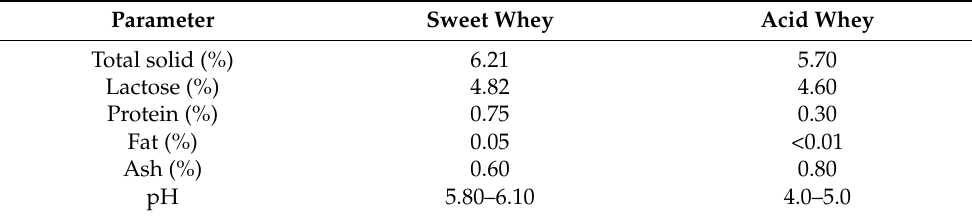
Table 1. Composition of different types of whey